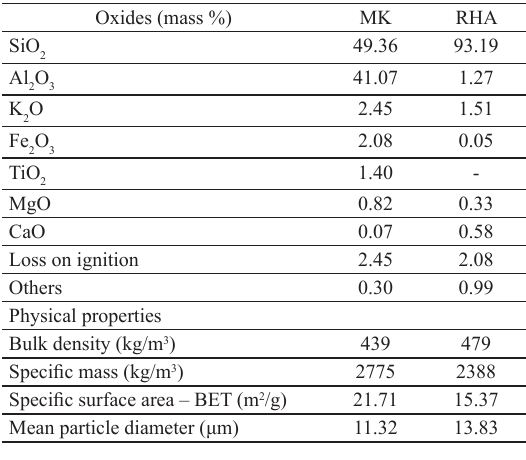
Table 1. Chemical composition and physical properties of metakaolin (MK) and rice husk ash (RHA).